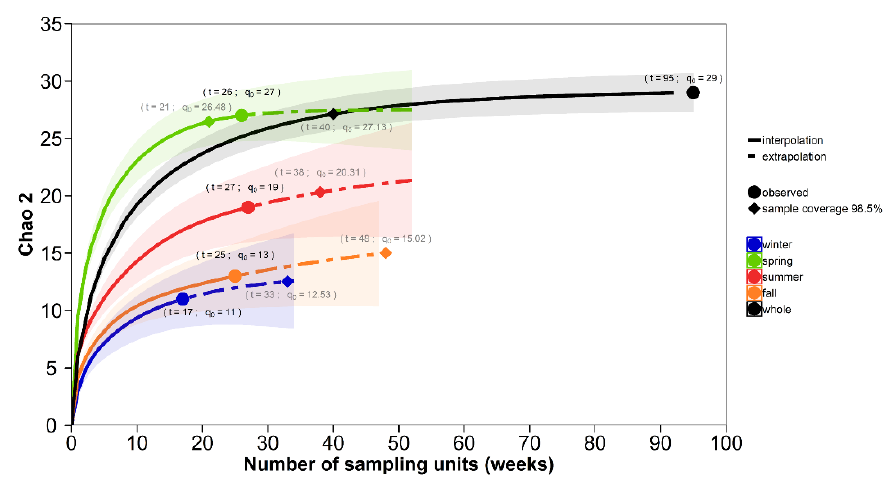
Figure 4. Seasonality pattern in Culicoides community structure: richness profile is trigged during spring. Sampled size-based rarefaction and extrapolation plot of Culicoides are shown to depict the seasonality richness pattern. Species accumulation curves ( Chao2 , q0 ) across the sampling weeks in each season (colors) are drawn. The solid line describes rarefaction or interpolated curve. The dashed line represents the accumulation profile up to double the reference sample size (extrapolation curve). The 95% confidence interval is the shaded area, and significance between profiles was the inference of their nonoverlapping. Observed q0 and the reference or complete sample size ( t ) are indicated with round dots and values detailed with bold legends. Diamonds, dots and grey legends show q0 and t necessary to attain 98.5% of the expected richness after coverage-based rarefaction and extrapolation analysis. The sample completeness curve showed that in each season, 97.5% of the sampling coverage was reached as soon the field sampling effort reached 27 weeks (Figure S1.7). Consequently, the deployed sampling effort was enough to analyze the seasonal dynamics in the vector assemblage. Culicoides richness and composition were linked through a pattern of nestedness, with the assemblage organized in a series of nested time-derived subassemblages (Figure 5A). Assemblages in weeks with low richness were formed with a limited set of species also occurring in high-richness weeks. Nestedness (NODF = 65.45; p < 0.01; matrix fill = 21%; Figure 5A) was more likely to be driven by richness and composition arrangement (NODF row = 69.25; p < 0.01; Figure 5C) than the pattern of species occurrence (NODF column = 53.80; p = 0.65; Figure 5B). Moreover, week order in the nested matrix depicted seasonality because species richness and composition followed a winter–fall–summer– spring gradient (subassemblage to full assemblage).